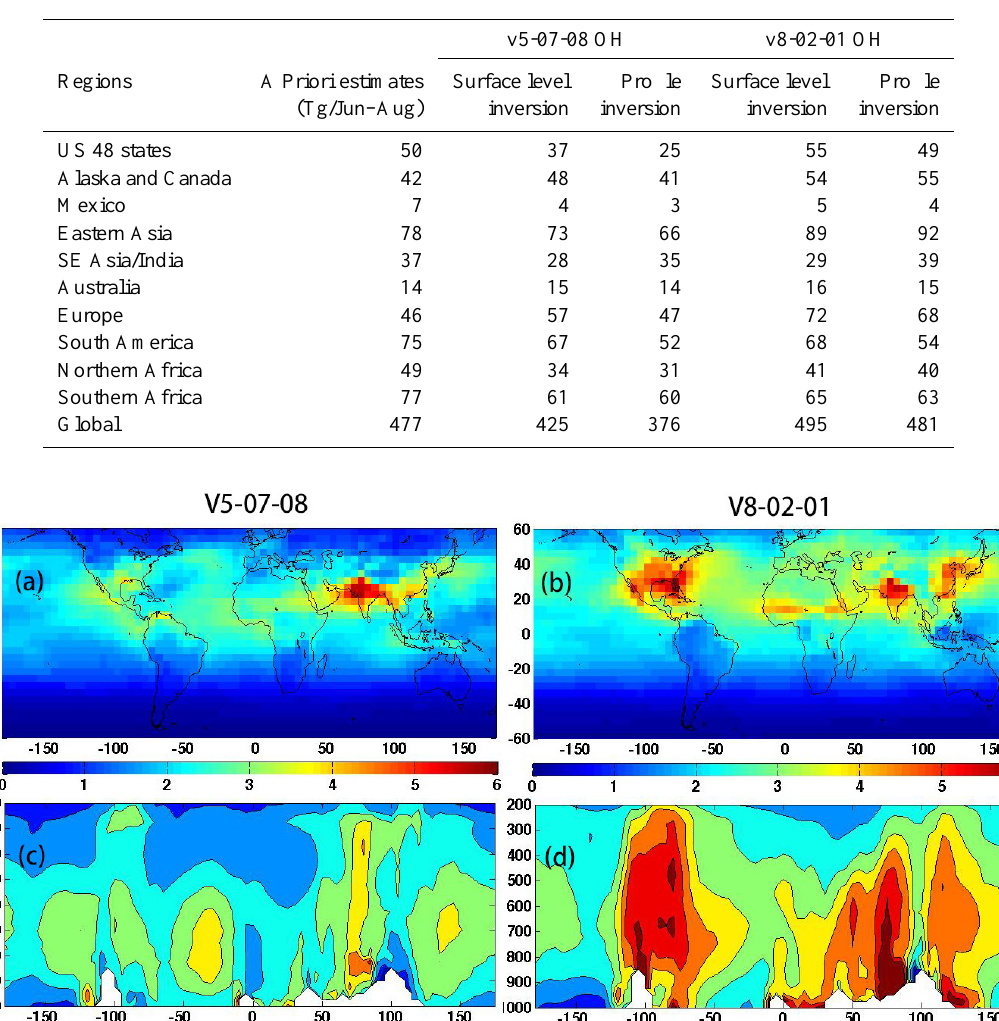
Table 3. Total CO emission in different regions, in June–August 2004, constrained by MOPITT surface level and tropospheric profile retrievals. The region definition is shown in Fig. 1.